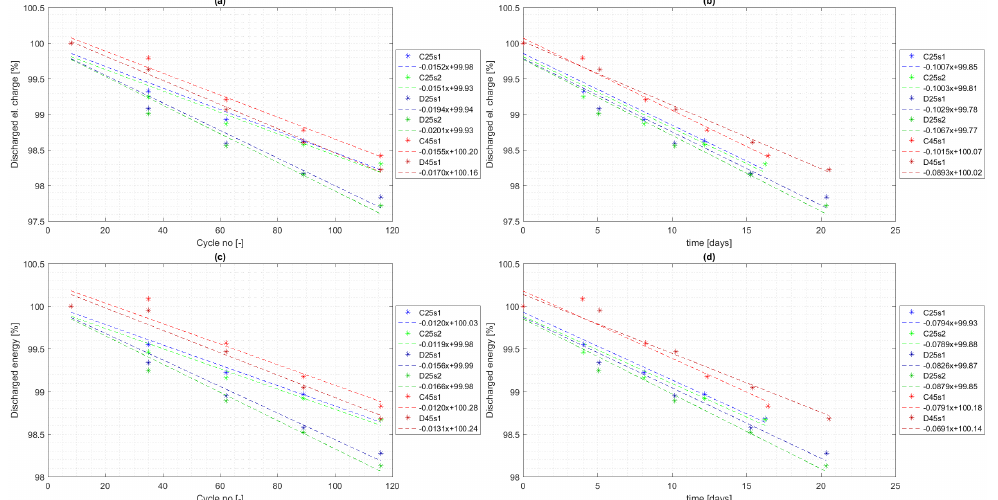
Figure 16. Capacity fade and energy decrease measured and regressed for all cycle aging cells at temperatures 25 and 45 ◦ C for all the second of the two consecutive capacity test cycles depending on cycle no. and time. All the values are normalized to the second cycle of the first two consecutive capacity tests (cycle no. 8), so that this value is equal to